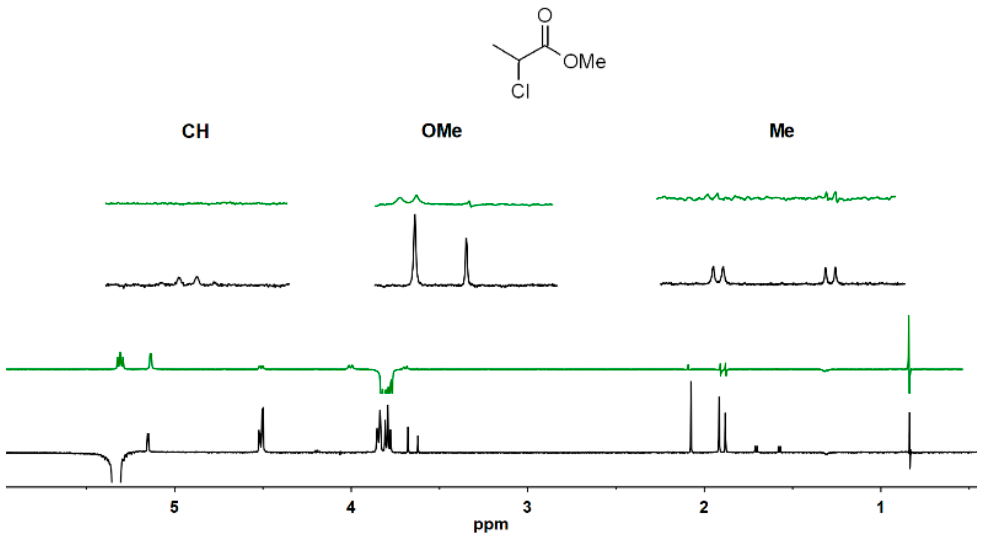
Figure 4. 1D ROESY (600 MHz, C 6 D 12 , 25 °C, mixing time = 600 ms) spectra of H3 (bottom, black) and H5 (top, green) protons of AcSiCD7 in a 1:1 mixture with MCP (20 mM). The comparison between the ROE spectra recorded for H3 and H5 protons points at